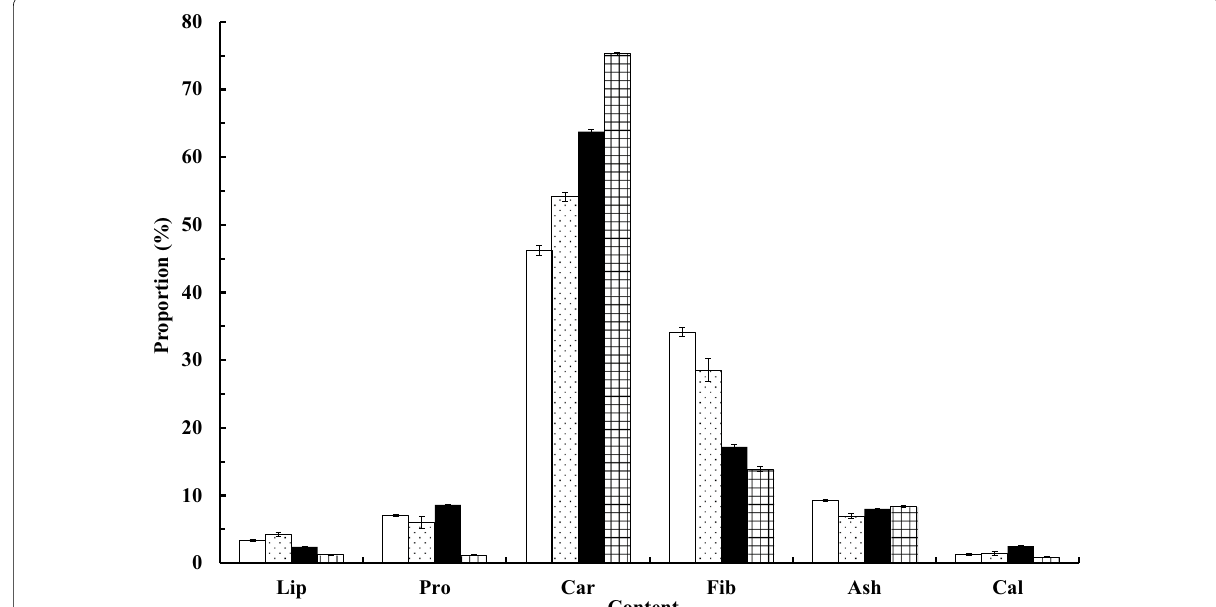
Fig. 3 Mean ( SE) nutrient contents (%) of lipids, proteins, carbohydrates, fiber, ash, and calcium in monoecious (open squaree: F. caulocarpa ; : F. ± subpisocarpa ) and dioecious (filled square: F. ampelas ; : F. irisana ) figs assessed in HTBC, Kenting